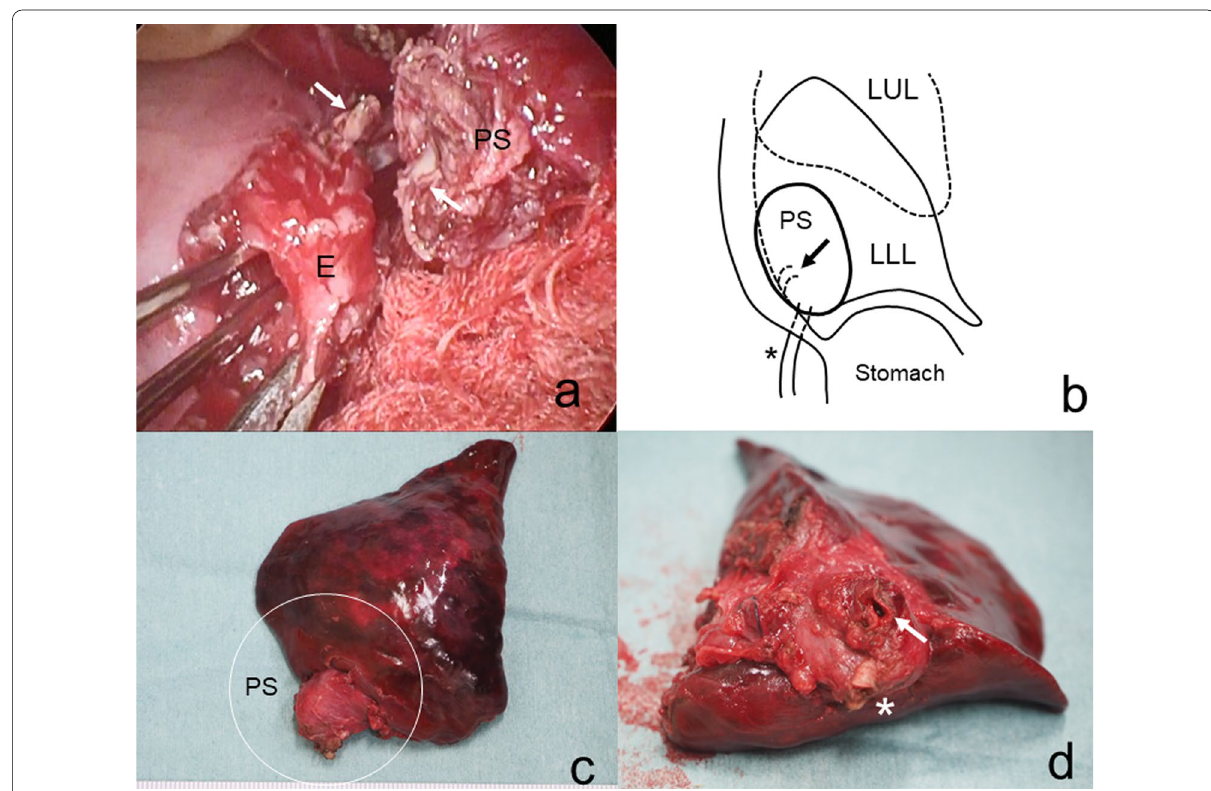
Fig. 3 Operative findings ( a ), schema ( b ) and resected specimen ( c , d ). Left lower lobectomy and resection of the intralobar